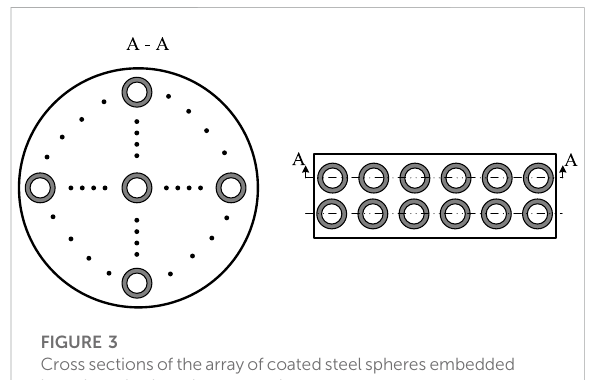
Crosssectionsofthearrayofcoatedsteelspheresembedded in a viscoelastic polymer matrix.